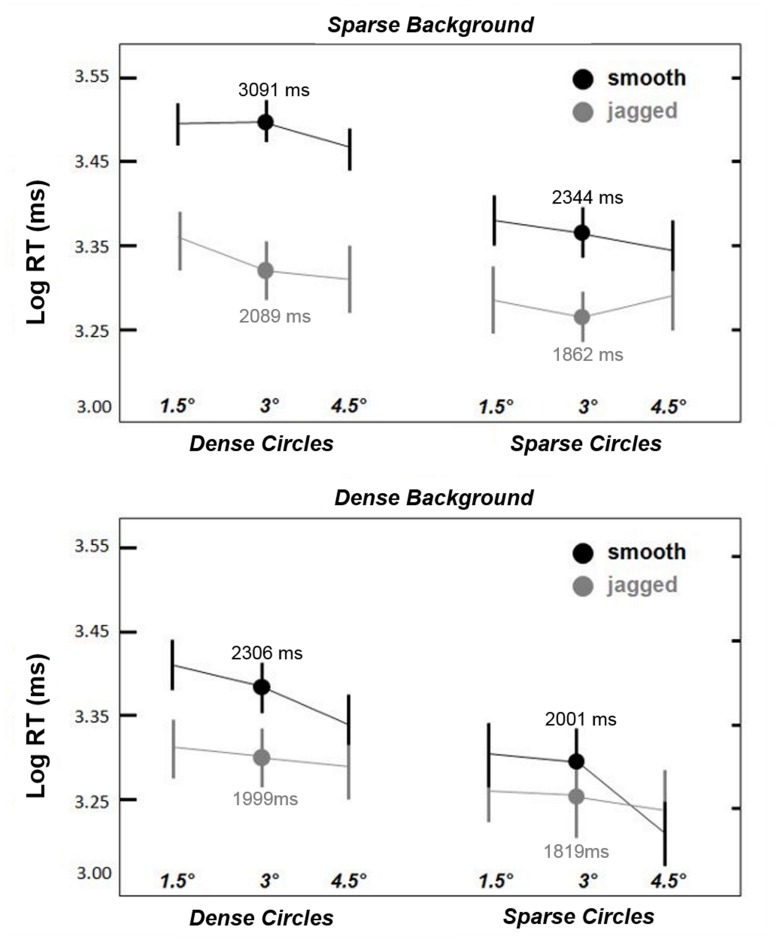
Results from Experiment 2. As in Experiment 1, smooth snake contours always remained visible longer than jagged contours. This effect was observed to be greatest for dense circles, and weakest for sparse circles paired with relatively dense backgrounds (lower right). The three circles sizes are indicated in ° visual angle along the x-axis. Dots indicate mean log RT for the intermediate circle size (3°). Error bars are 95% confidence intervals.